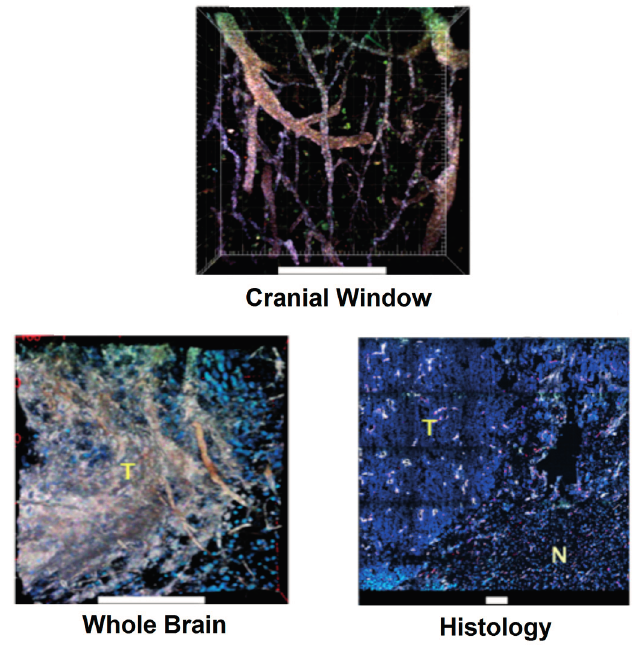
Figure 3. Two-photon luminescence (TPL) imaging of cerebral microangiogram, Hoescht 33342-stained whole brain, and DAPI/CD31-stained cryosectioned histology. AuNSs are white. T: tumor. N: normal. Scale bar: 200 μ m [36]. (Adapted from Ref.